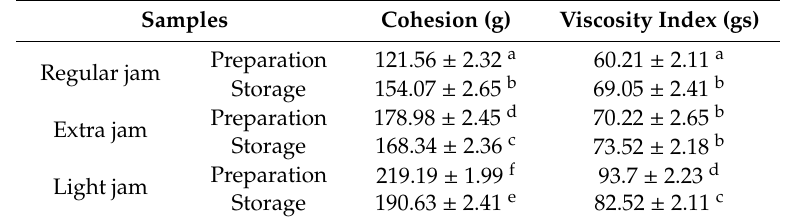
Table 6. Parameters of the texture of regular, extra and light tart cherry jams after preparation and after storage at room temperature for eight